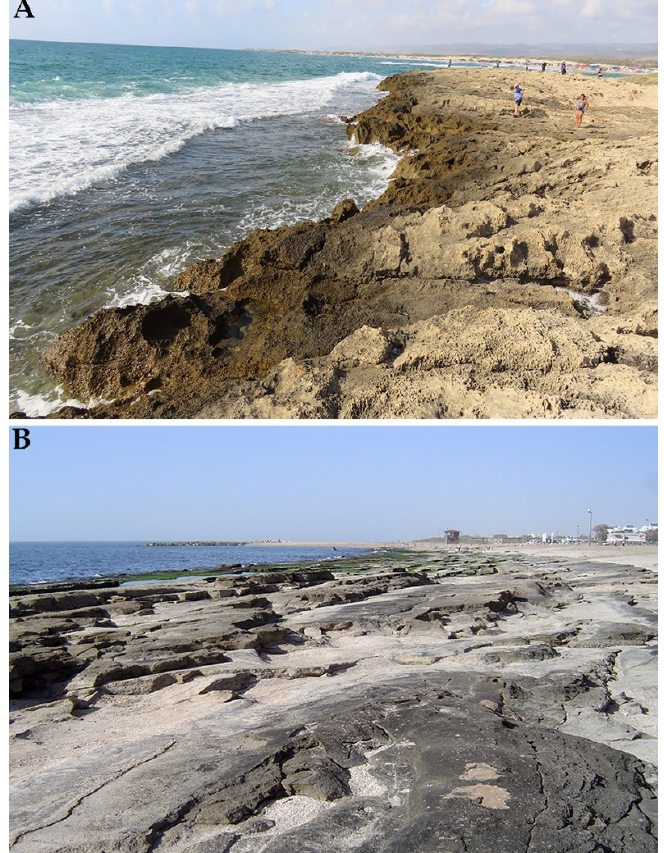
Figure 4. Rocky coasts: typical kurkar rocky coast including abrasion platform—for example,